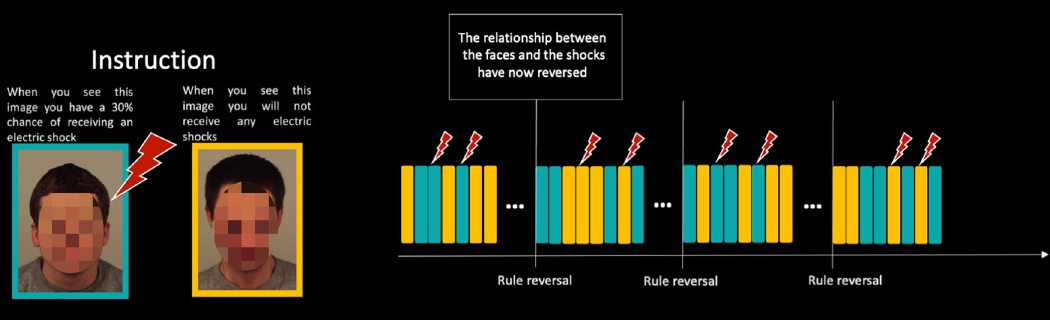
Figure 1. Instructions and block design of the aversive fear learning